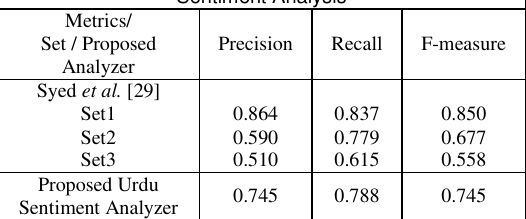
Table 4: Comparison with the previous work in Urdu Sentiment Analysis Metrics/ Set /